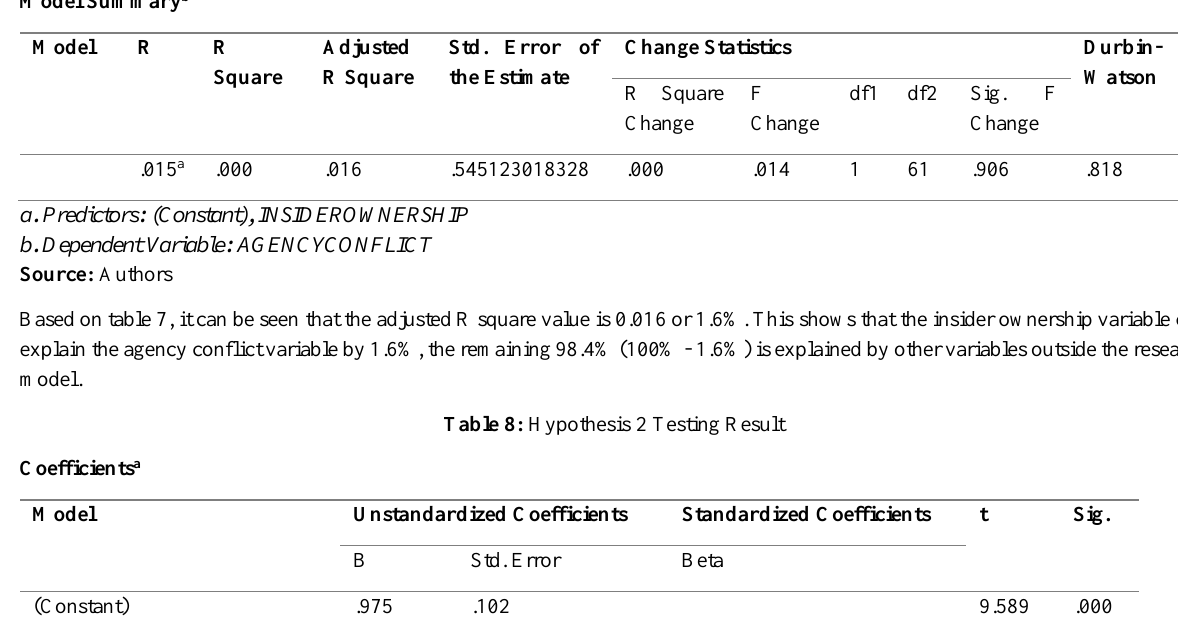
Table 7: Hypothesis 2 Testing Result